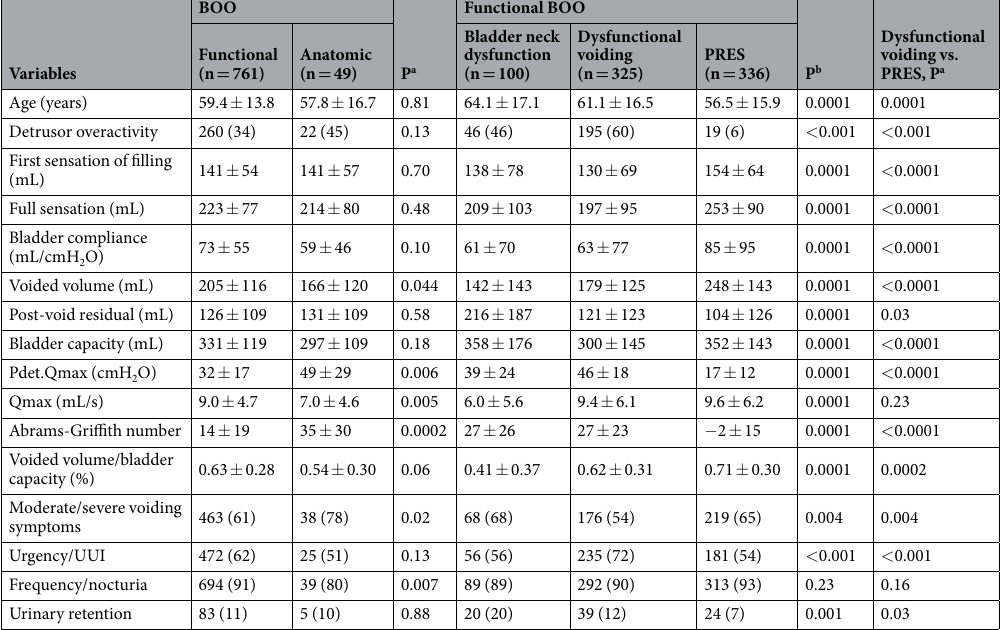
Table 2. Comparisons of videourodynamic diagnoses with bladder outlet obstruction (n = 810). PRES = poor relaxation of the external sphincter. Data expression and other abbreviations are the same as in Table 1. a By Wilcoxon rank-sum test or chi-square test. b By Kruskal-Wallis test or chi-square